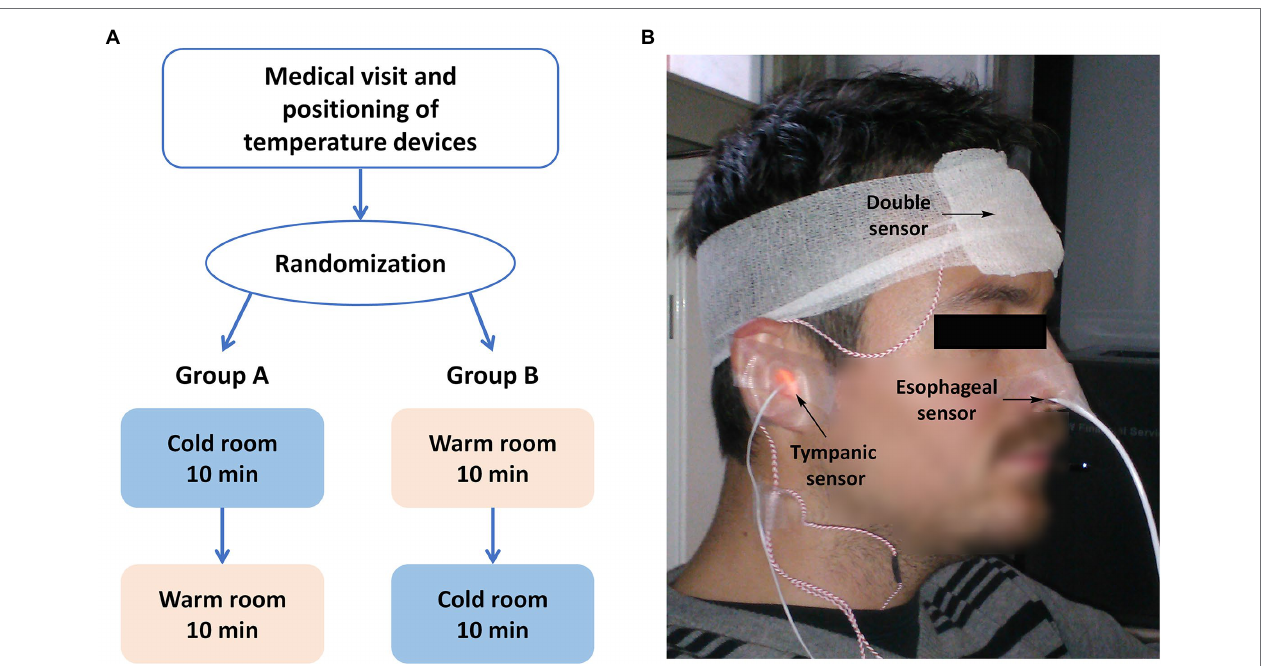
FIGURE 1 | Study design (A) and experimental setup (B) . (A) The study was a randomized, cross-over study, where each participant underwent two sets of measurements, that is, measurements in a warm room (room temperature of 23.4 ± 0.4 ° C) and in a cold room (room temperature of –18.7 ± 1.0 ° C), and the order of the two conditions was the randomization variable. (B) Patients equipped with the devices for temperature monitoring: double sensor, esophageal, and tympanic thermometers.